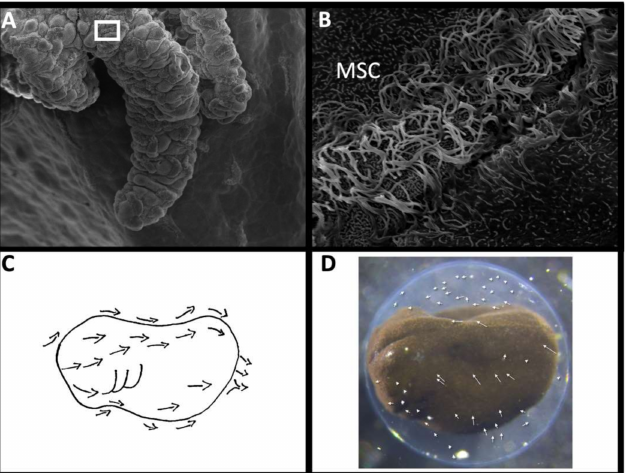
Figure 3. Multiciliated surface cells (MSC) in amphibian embryos. ( A , B ) Scanning electron micro- graphs of the eastern redbacked salamander, Plethodon cinereus . ( A ) external gills 350 × magnification; and ( B ) white box in A, single MSC with tufts of external cilia (500 × ). ( C ) Antero-posterior mi- crocurrents created around woodfrog ( Rana sylvatica ); and ( D ) Vectors represent detectable particle displacement over two seconds in a timelapse of wild-collected R. sylvatica. MSCs create vortices within the closed environment of the egg capsule that move both the embryo and its extraembryonic fluid. Panel C is redrawn from Assheton [174], reproduced with permission from the Quarterly Journal of Microscopical Sciences (copyright now under The Company of Biologists),